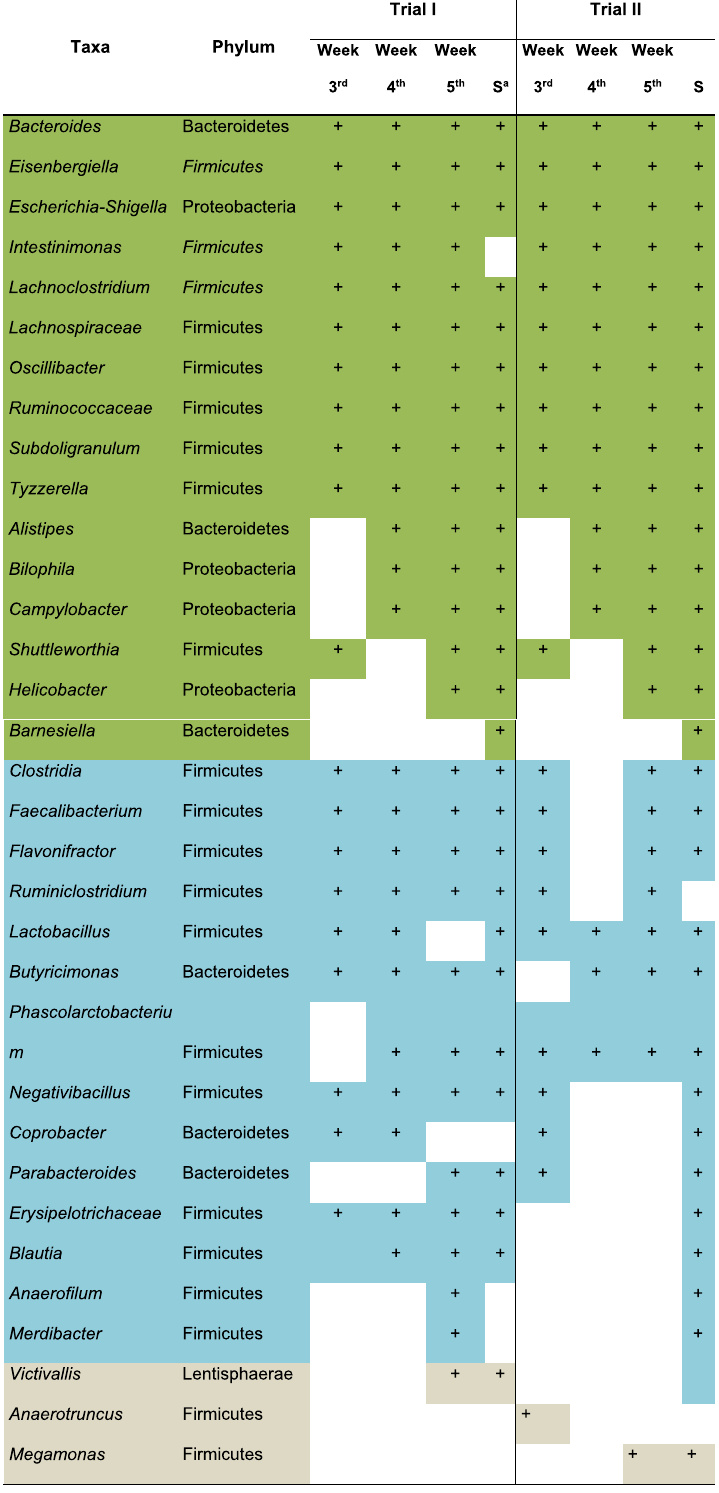
Table 3. Core microbiome, at genus level, of the last 3 weeks of the broilers’ production cycle and at the slaughterhouse, for the two trials. Presence (+) of taxa is shown over time with their respective phylum. A green background indicates taxa that behave similarly in both cycles. Patterns with variable behavior for both trials are indicated in blue. Brown corresponds to taxa that are part of the core microbiome (> 50% of the samples) only in the first or second cycle. S shows the results at the